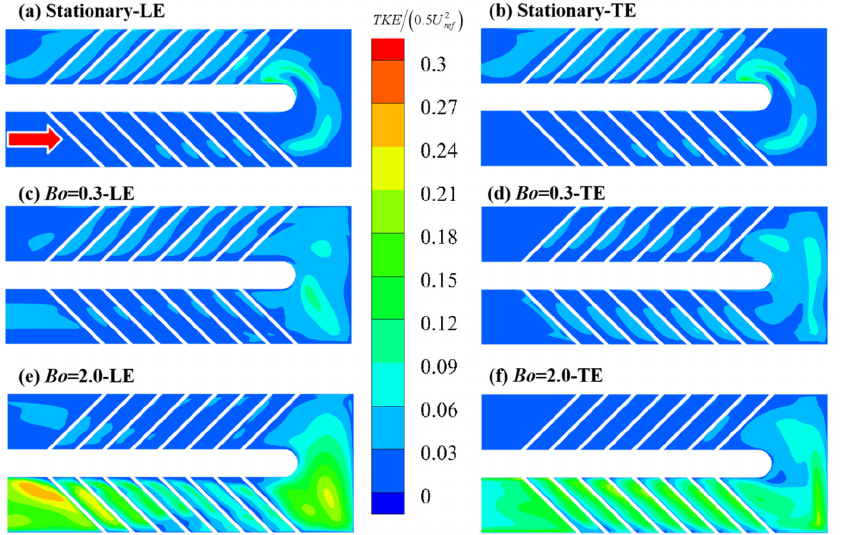
Figure 11. Non-dimensional TKE in meridian planes at Z / H = 0.9 (near LE) and 0.1 (near TE) of ribbed channel.